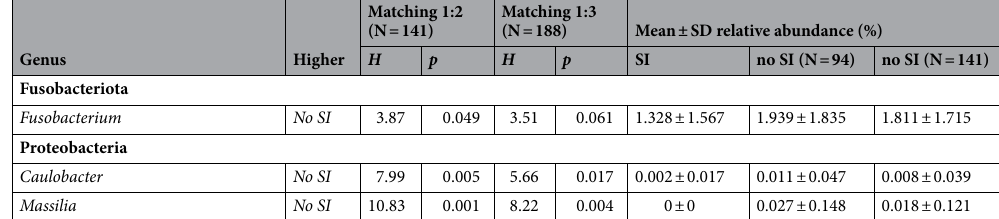
Table 4. Salivary bacterial genera and closest cultured relative species that are differentially abundant in suicidal ideation (SI) after controlling for sex and diet. Relative abundances of significant differentially abundant closest-species-relatives in individuals without SI (NOSI) and individuals with SI (SI) after propensity score matching on sex and diet factors. Two models, with 1:2 and 1:3 matching of SI to NOSI,